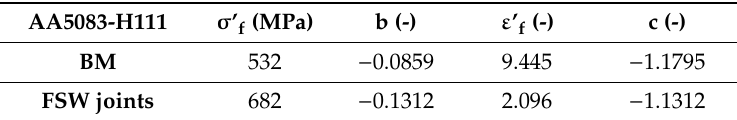
Table 4. Estimated strain-life relationship